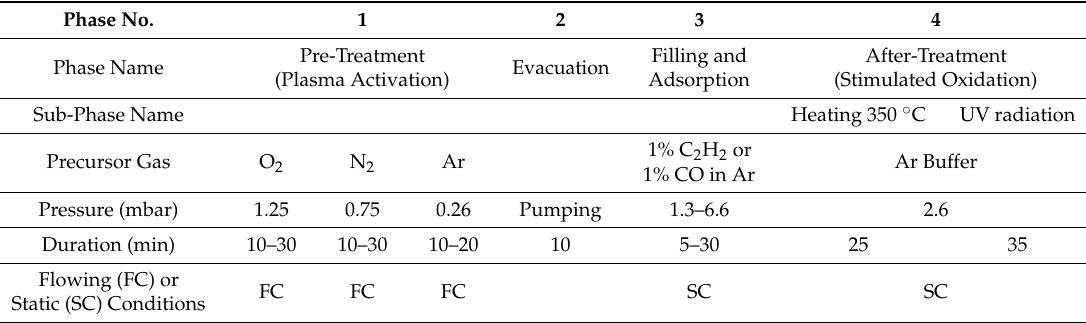
Table 2. Experimental phases of the measurements [51], © IOP Publishing. Reproduced with permission. All rights reserved.